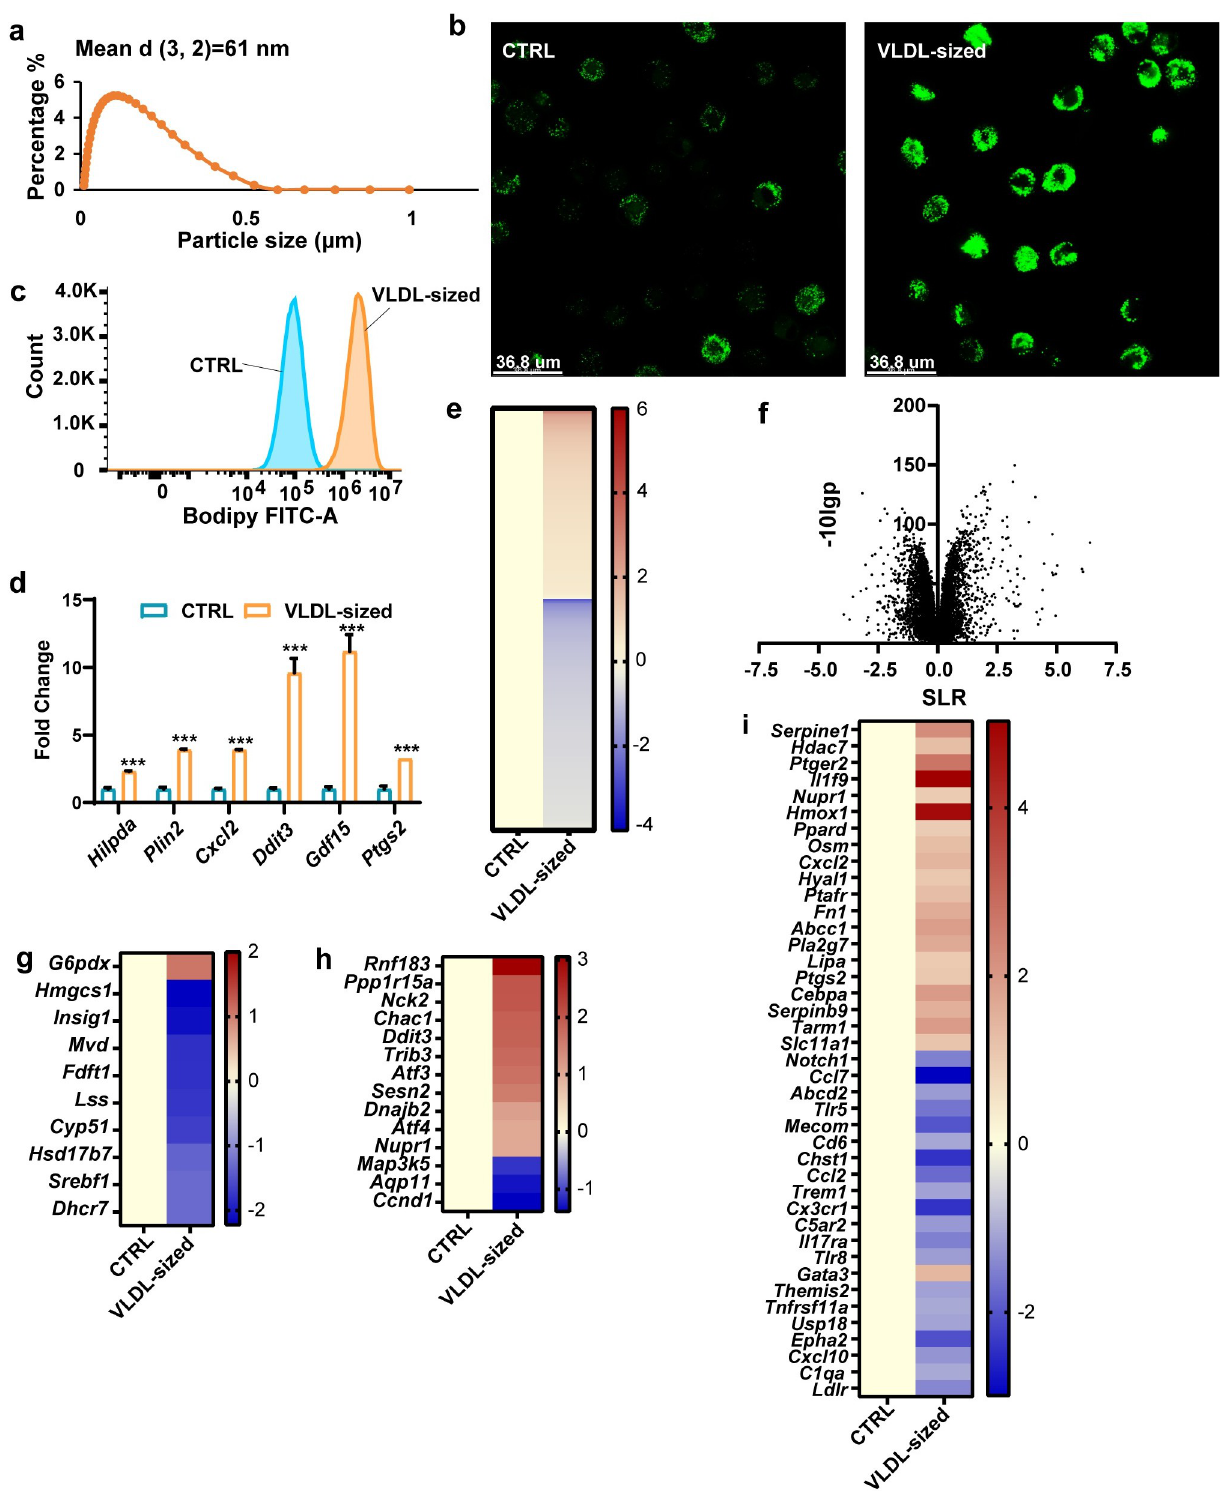
Fig 1. VLDL-sized emulsion particles promote lipid accumulation in cultured macrophages. AU : AbbreviationlistshavebeencompiledforthoseusedinFigs 1 (cid:0) 8 : Pleaseverifythatallentriesarecorrect : (a) The particle size distribution of VLDL-sized emulsion particles as determined by mastersizer 3000. (b) BODIPY 493/503 staining of intracellular neutral lipids in human primary macrophages treated with 0.5 mM VLDL-sized emulsion particles (referred to as VLDL-sized) for 6 hours ( n = 6). (c) Mean fluoresce intensity (FITC-A) measured by flow